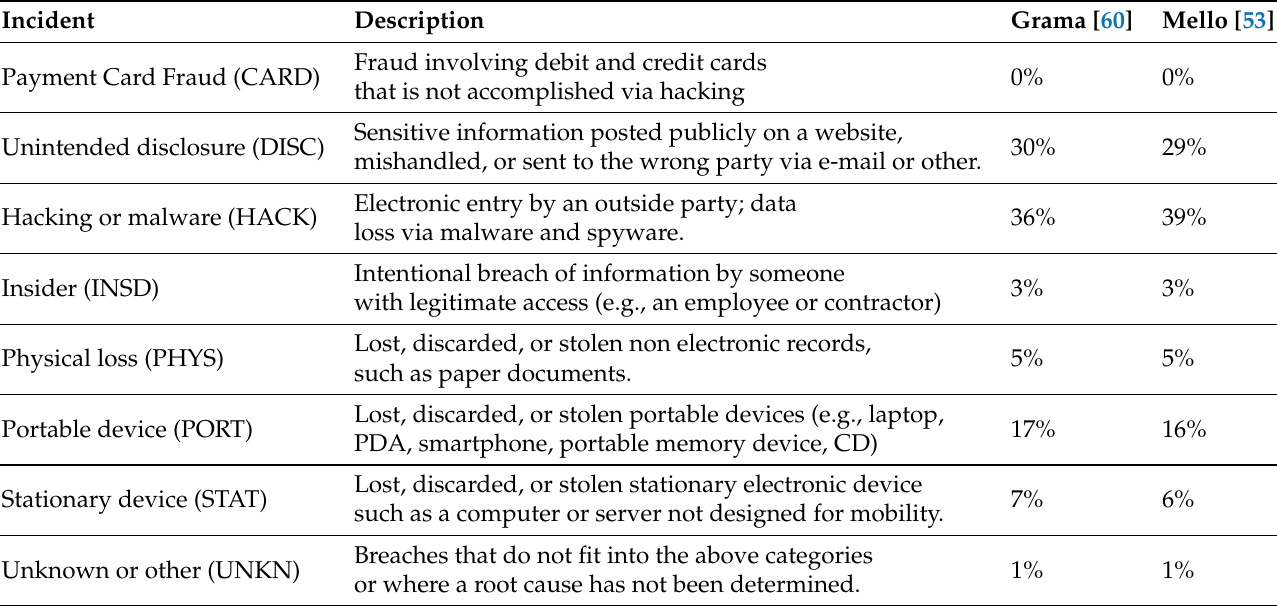
Table 8. Incident statistics from Grama ( n = 551) and Mello ( n = 604), both applying the Privacy Rights Clearinghouse (PRC) data for analysis.